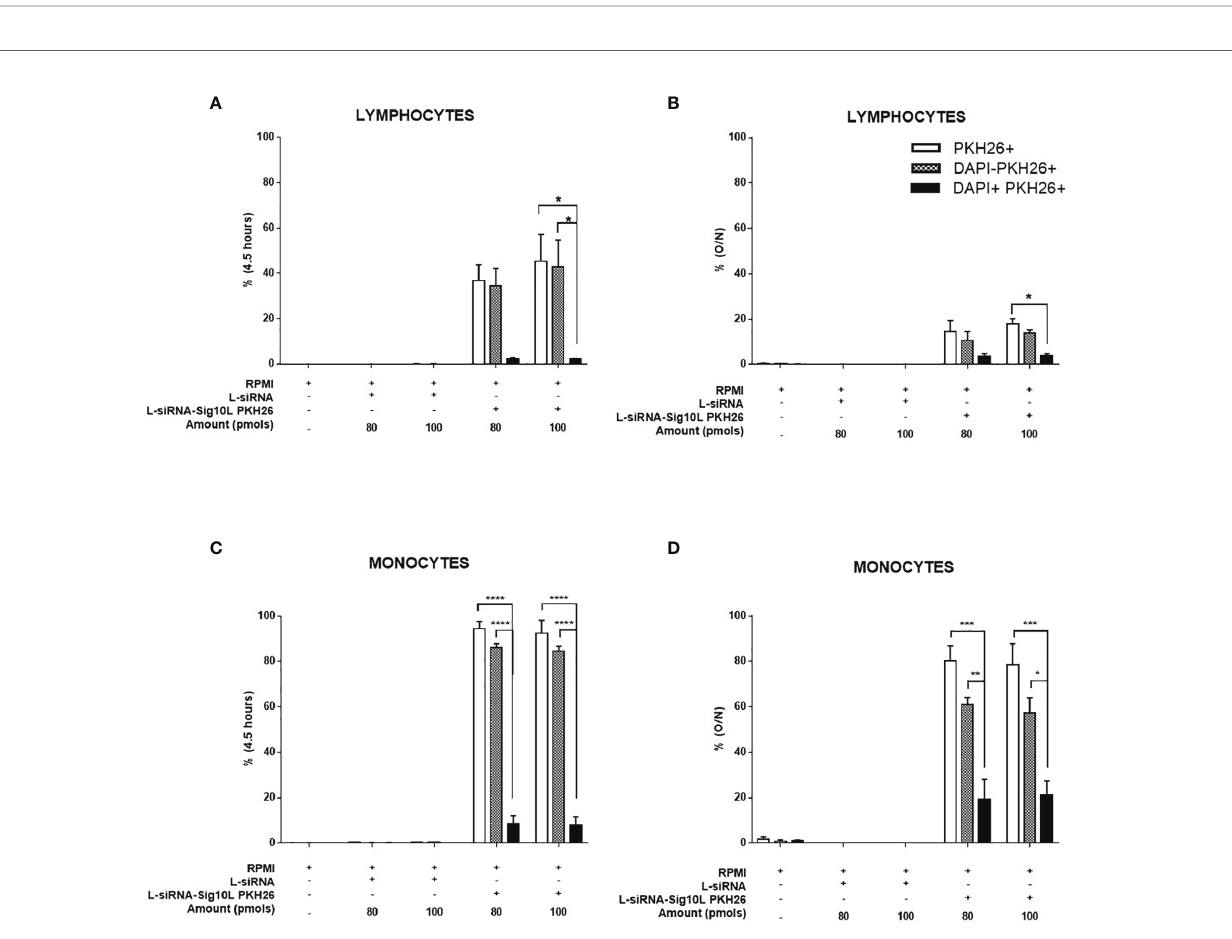
FIGURE 4 | Evaluation of PKH26-labeled LiposiRNA-Sig10L toxicity on HD PBMC. Flow cytometry analysis of HD PBMC treated for 4.5 h or O/N with the indicated doses of unlabeled LiposiRNA or PKH26-labeled LiposiRNA-PEGF9. Histogram shows the percentages of total PKH26+, live PKH26 + (DAPI − ) and dead PKH26 + (DAPI+) among lymphocytes (A, B) and monocytes (C, D) upon the indicated treatments performed for 4.5 h (A – C) and O/N (B – D) . Gating strategy is illustrated in Figure S2 . Data are expressed as mean ± SEM of n = 3 HD samples. *p < 0.05, **p < 0.01, ***p < 0.001, ****p <